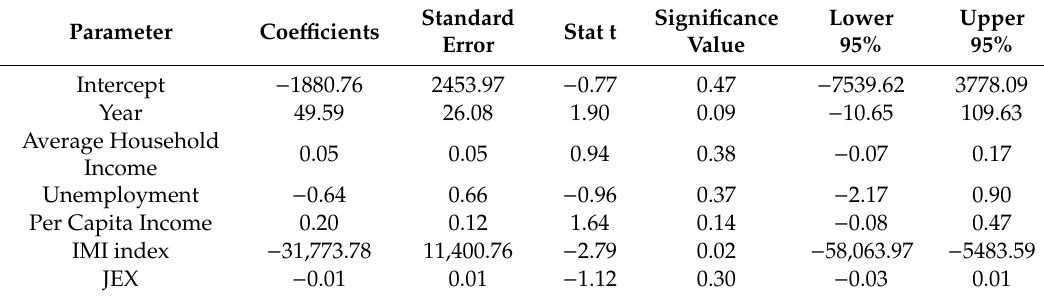
Table 5. Output of real estate pricing